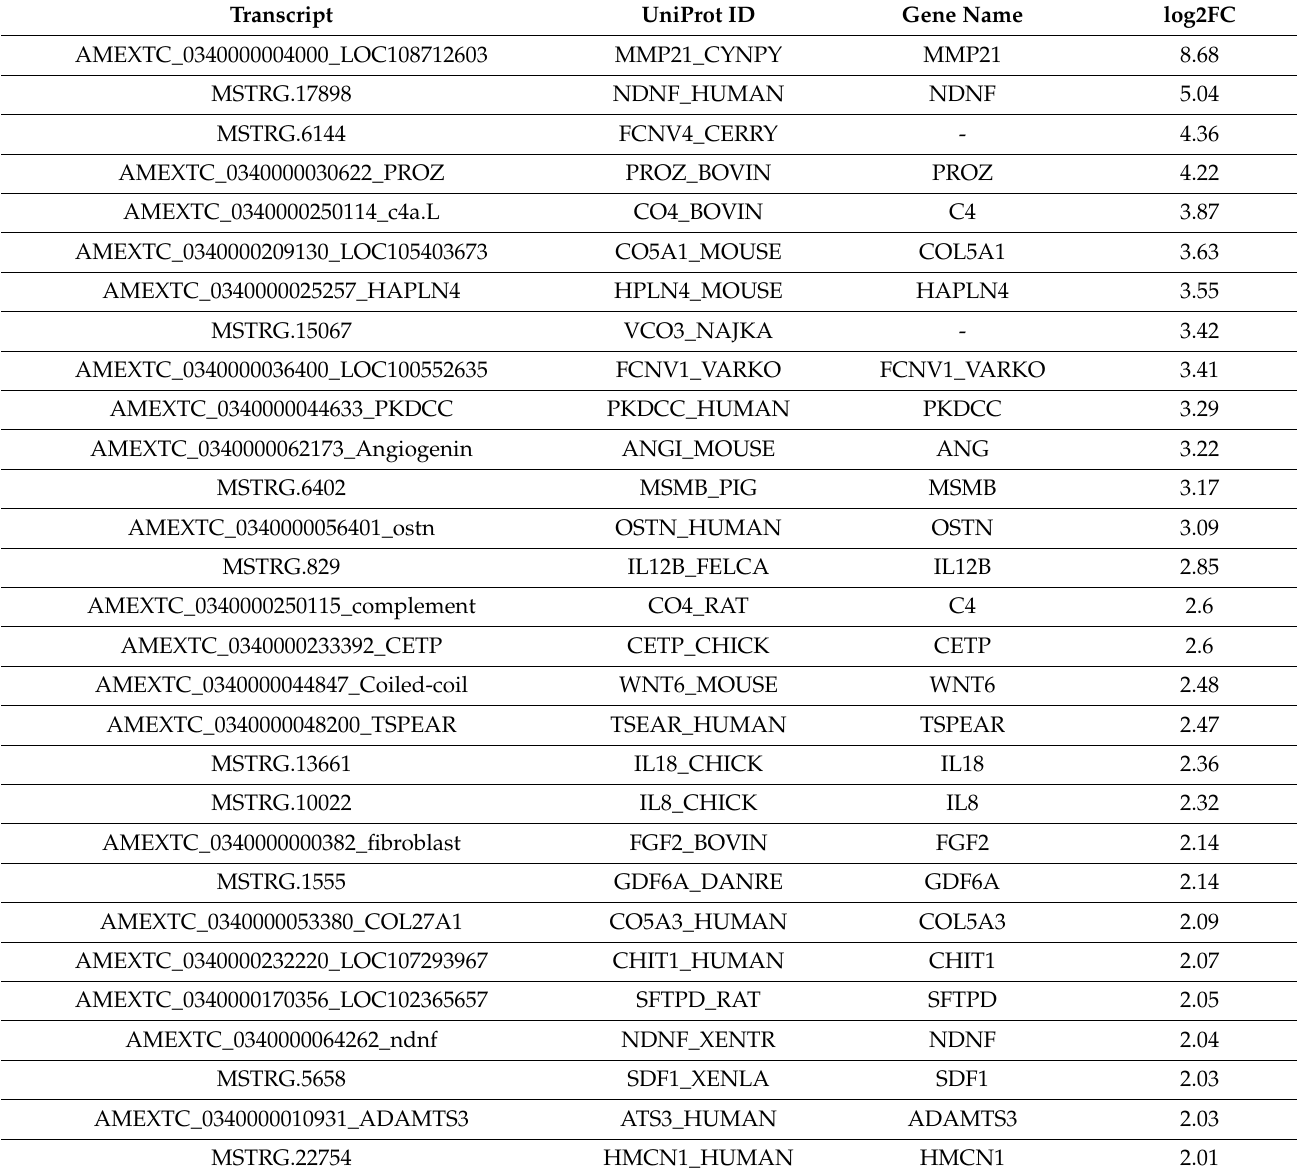
Table 4. Genes encoding secretory proteins. Transcript name is given as “AMEXTC” if found in the reference genome or “MSTRG” if identified as novel by StringTie. Gene names are left blank for UniProt entries without a listed gene